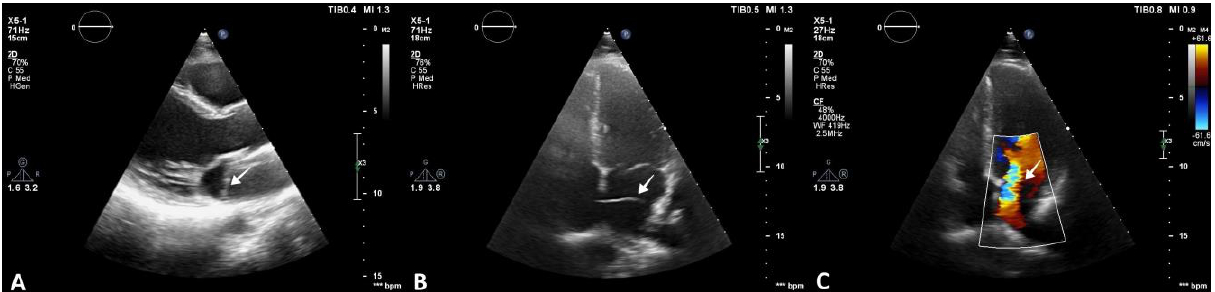
Figure 2. Transthoracic echocardiography revealing CTS. ( A ) Parasternal long-axis 2D view showing an echodense, membranous structure within the LA (arrow). ( B ) Apical four-chamber 2D view showing the membrane bisecting the LA (arrow). ( C ) Apical four-chamber 2D view and color Doppler window placed over the LA, highlighting turbulent flow across the membrane (arrow).